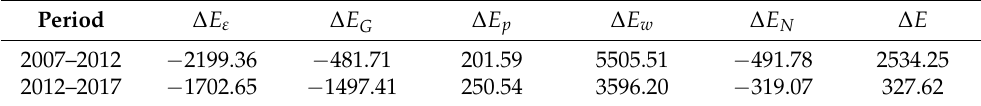
Table 2. SDA results of changes in national production-related carbon emissions